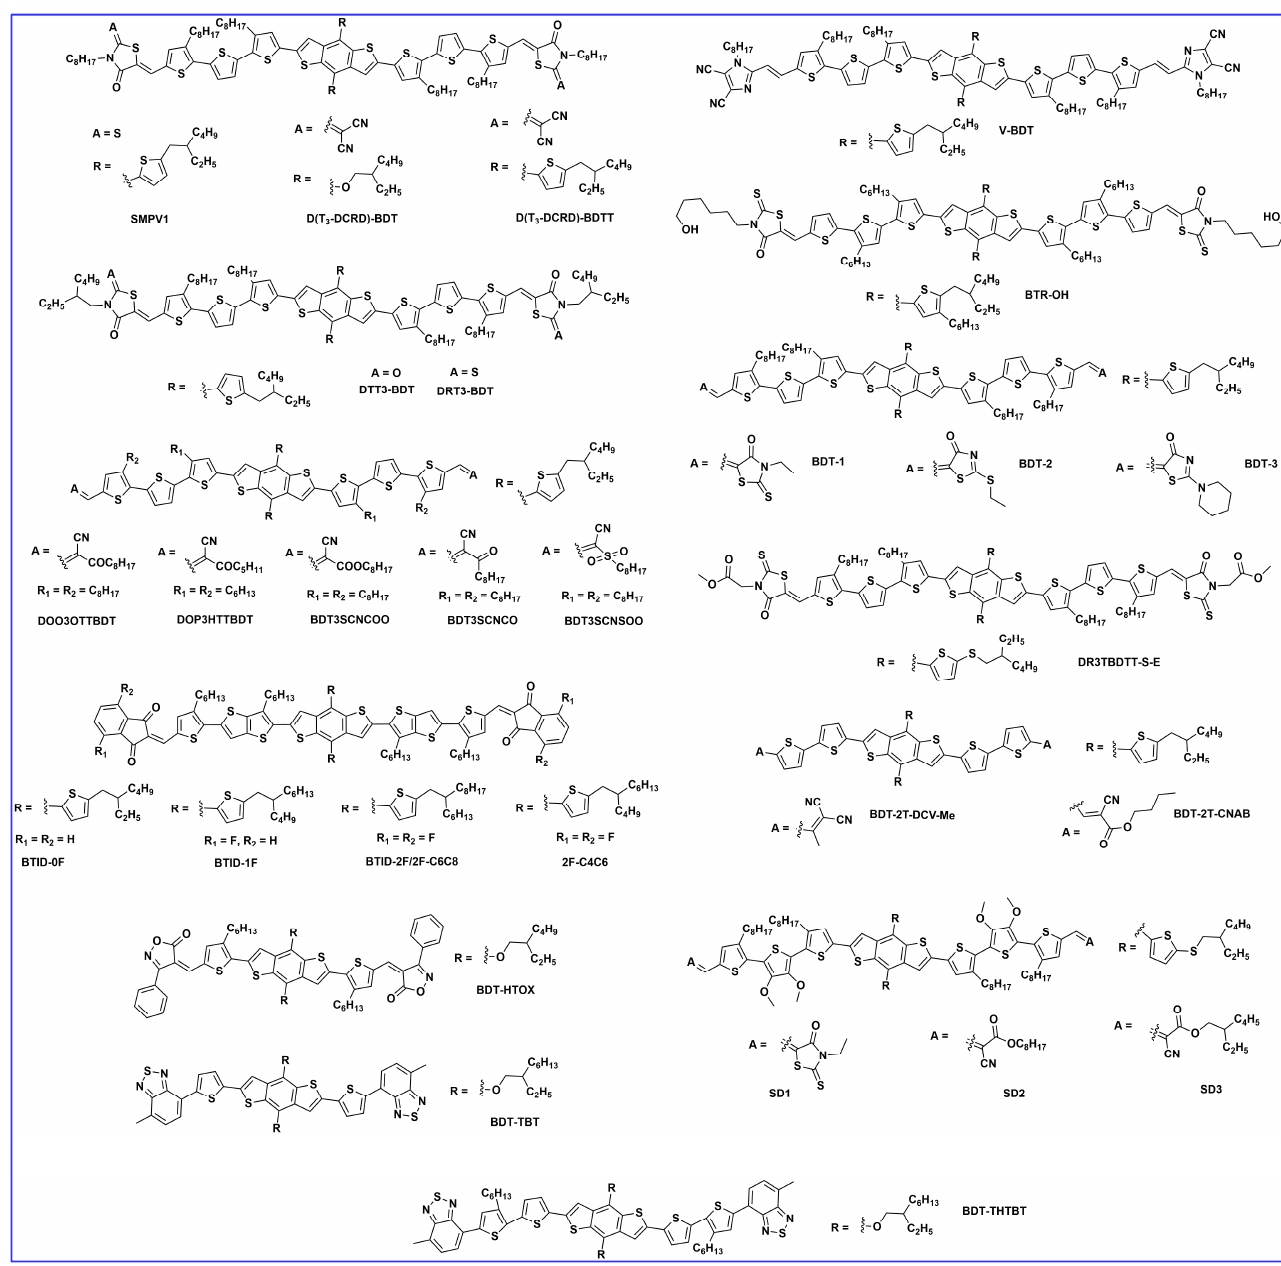
Figure 4. BDT molecular structure via end group engineering.